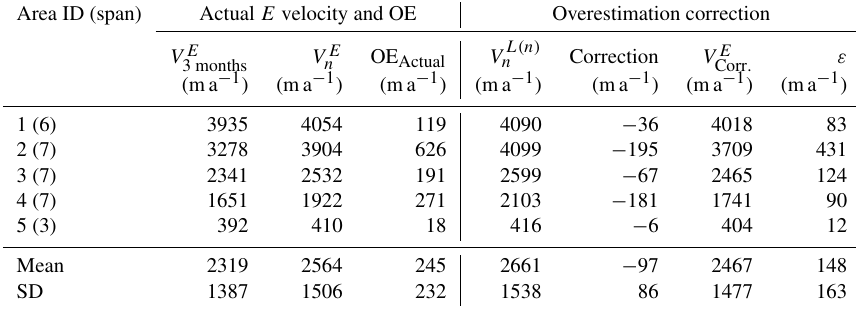
Table 3. Application of the OE correction method in PIG. “Actual E velocity and OE” includes E velocities of 3-month and n -year spans and their differences as OEs. “Overestimation correction” presents n -year L velocities from n -year-span map, OE corrections, corrected E velocities, and residuals (or errors) after